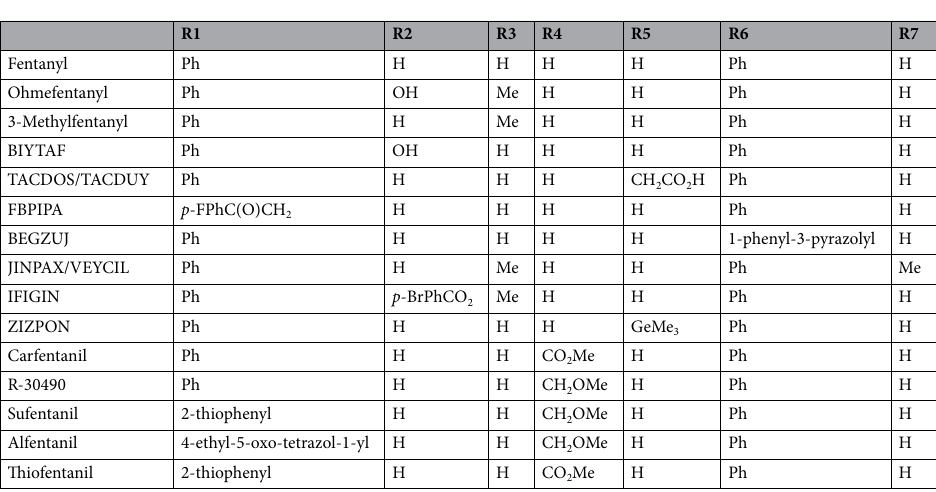
Table 1. Molecular structures of fentanyl and its